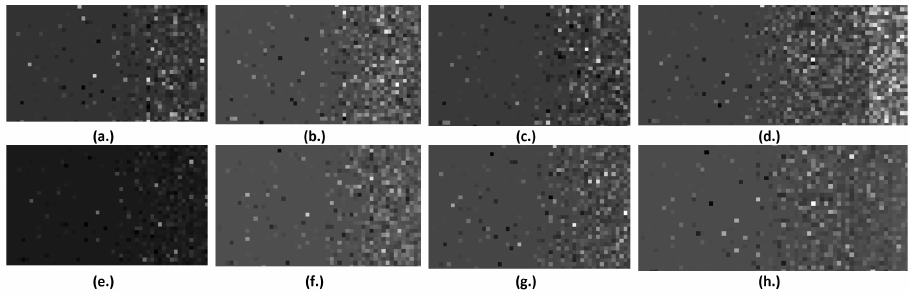
Figure 9. The activation maps of the best performing classifiers: ( a. – d. )—the class of HCC for B-mode US and CEUS input (ResNet), respectively for feature level fusion (DenseNet, multiplication) and classifier level fusion (DenseNet + ResNet); ( e. – h. )—the class of PAR, for the same